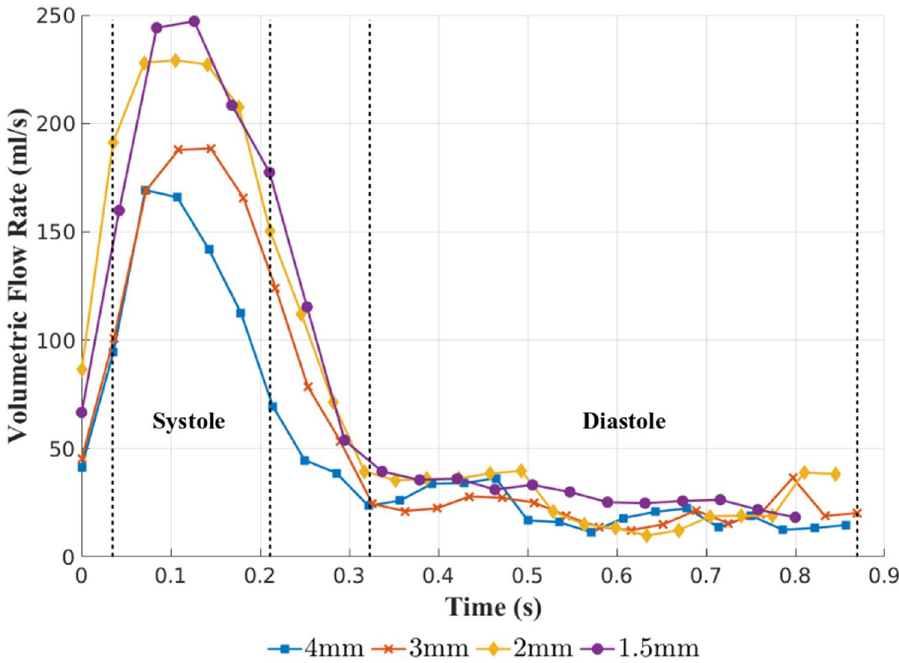
Figure 4. Volumetric flow rates at the inlet determined using 4D-Flow MRI data for all four scan resolutions. The systolic and diastolic phases over which results are averaged are also shown, enclosed by dashed lines.